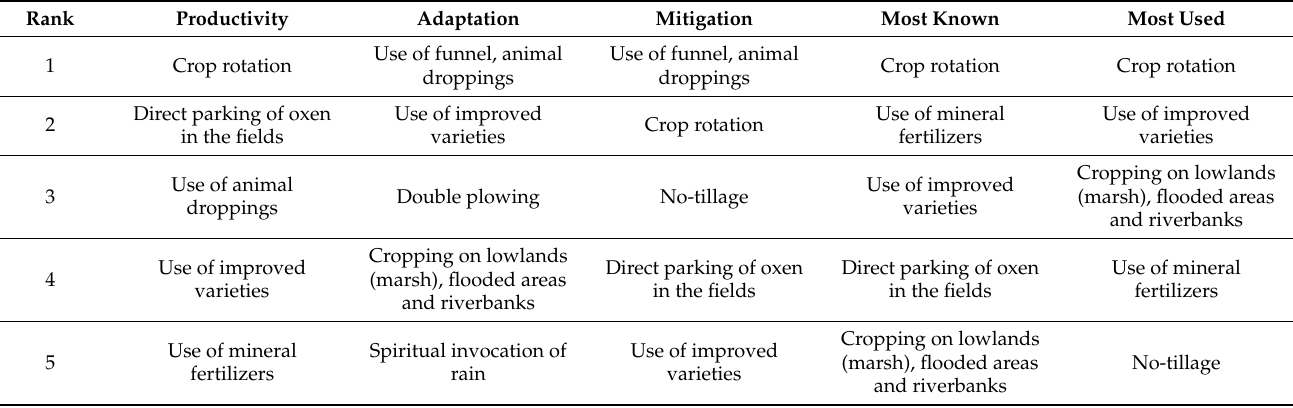
Table 2. Classification of the top 5 CSAP by the frequency of agreement for each CSA